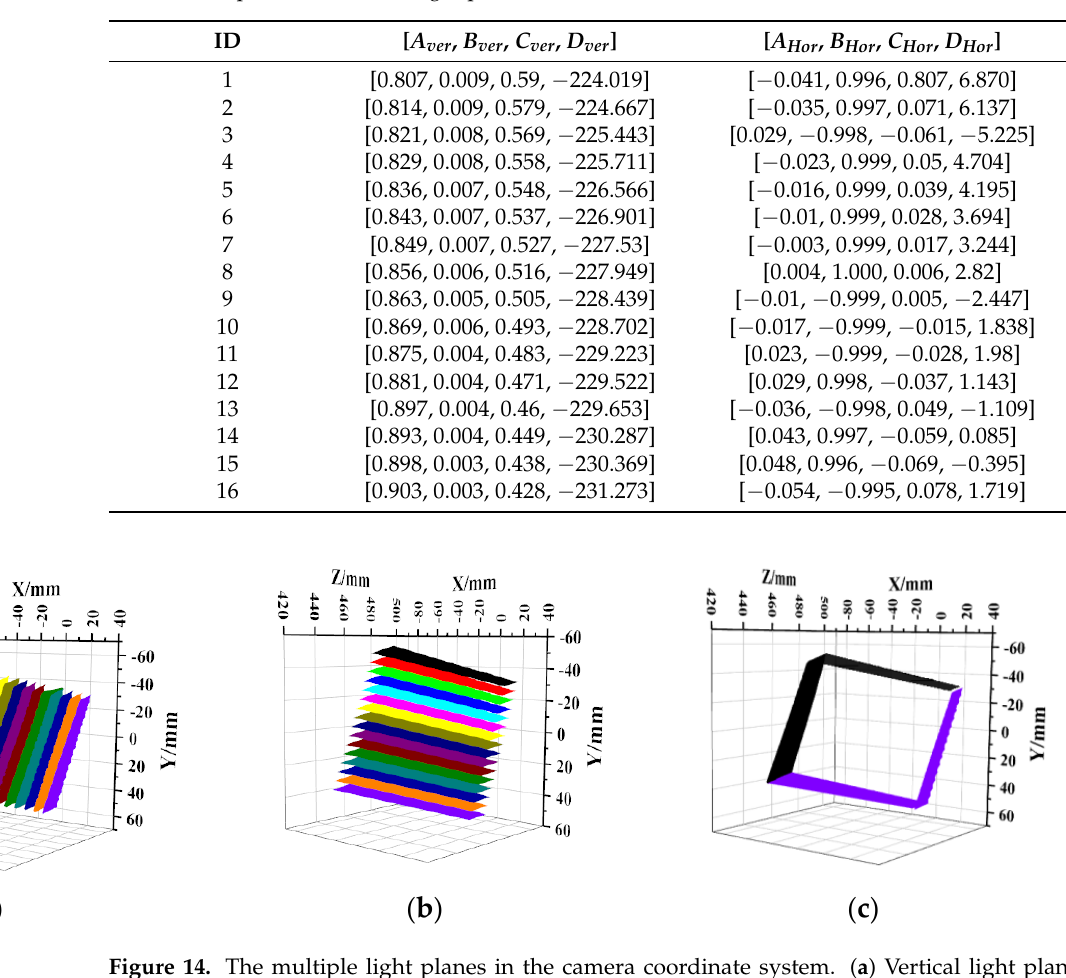
Table 5. Accuracy verification experiment.